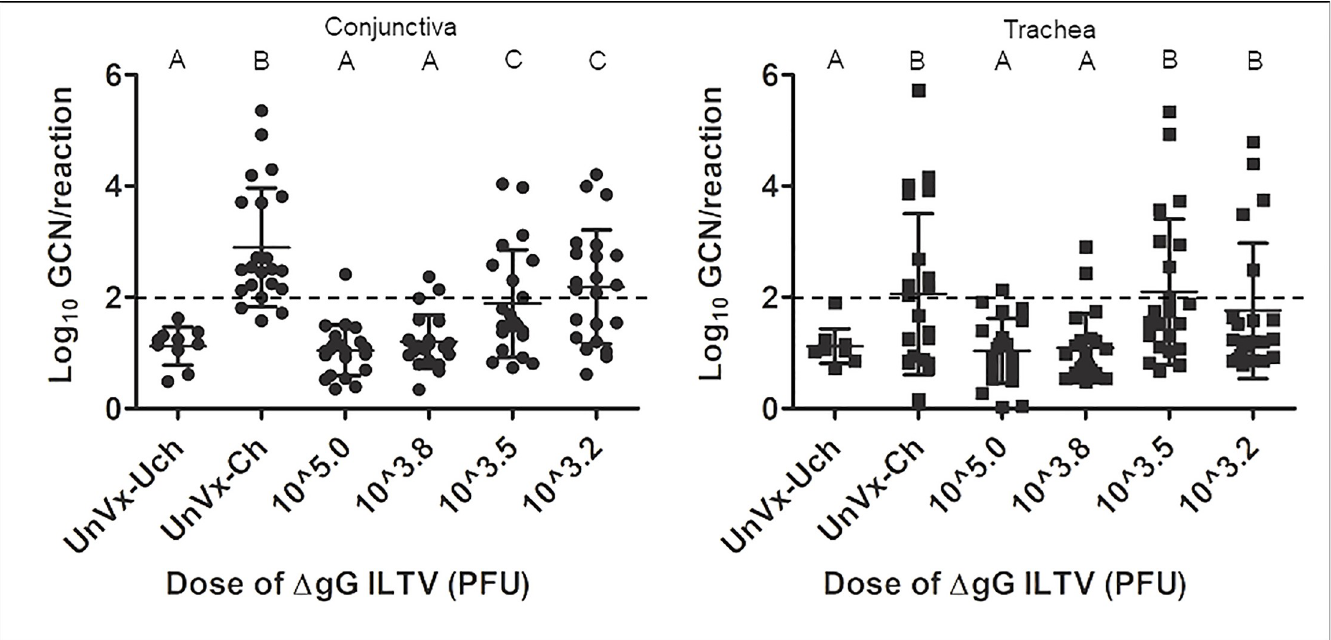
Fig 1. Scatter plot of concentrations of ILTV as determined by qPCR on extracts from conjunctival or tracheal swabs of unvaccinated birds and birds vaccinated with different doses of Δ gG ILTV at day 7 after challenge with class 9 ILTV. Values labelled with the same upper-case letter (A, B, C) were not significantly different (P > 0.05, one-way analyses of variance in conjunction with Dunnett’s Multiple Comparisons test) in each panel (conjunctiva or trachea). GCN = genome copy number, UnVx-Uch = unvaccinated and unchallenged, UnVx-Ch = unvaccinated and challenged, PFU = plaque forming units. Means (horizontal solid lines) and standard deviations (error bars) are also shown. The cut off value for positivity was 100 genome copies per reaction and this is indicated by a horizontal dashed